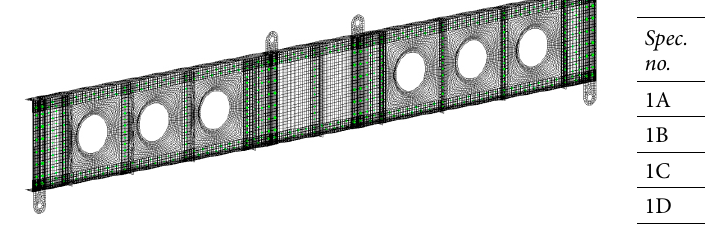
Table 2. Summary of relevant loads for all specimens